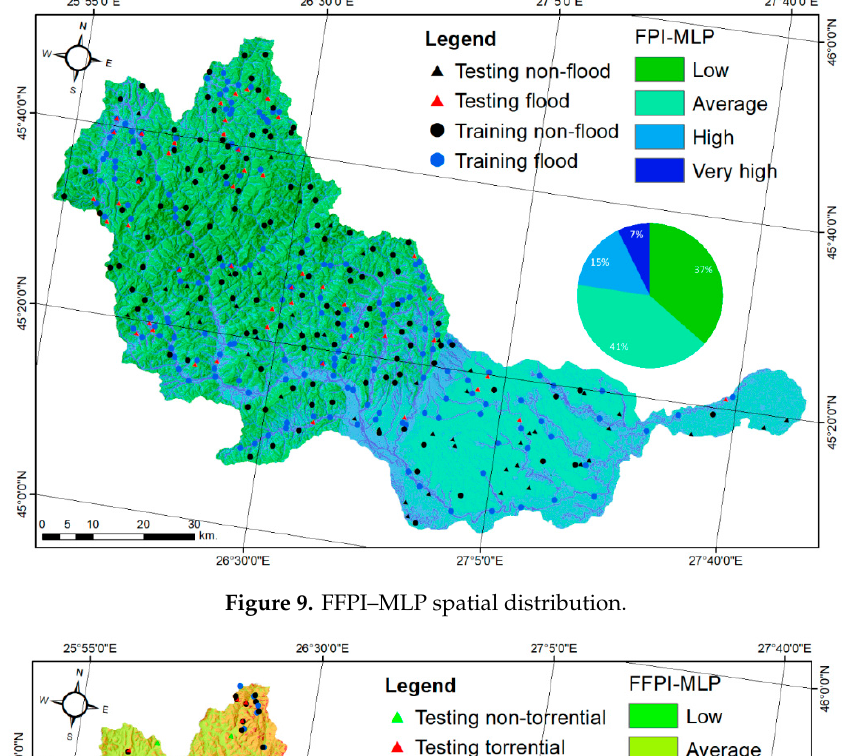
Figure 9. FFPI–MLP spatial distribution.